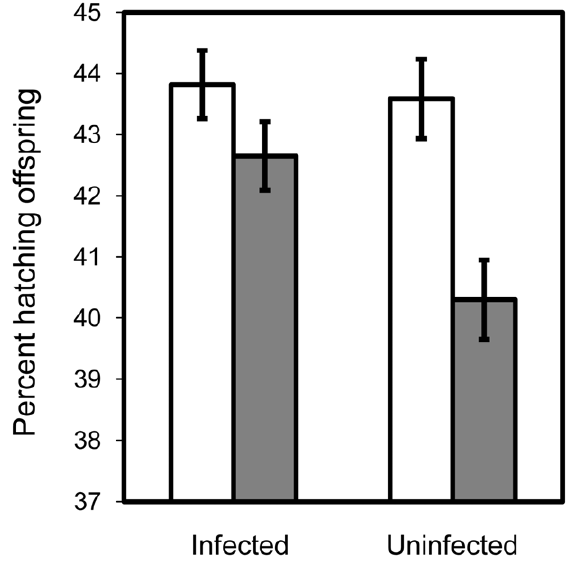
Figure 2. Effect of Wolbachia on egg-to-adult survival. Proportion of hatched eggs separated by sex for the infected (LH M ) and uninfected population (LH M -W - ). doi:10.1371/journal.pone.0016448.g002 PLoS ONE |